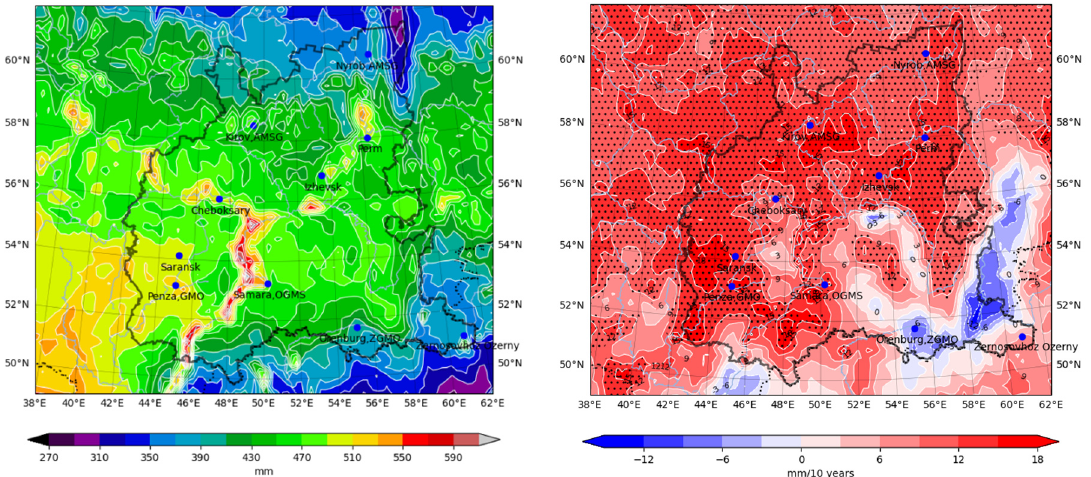
Figure 4. Spatial distribution of annual vaporization ( E ) (left map) and the annual vaporization LTSC value (right map) (according to ERA-5 reanalysis data) in the Volga Federal District during 1966–2021.